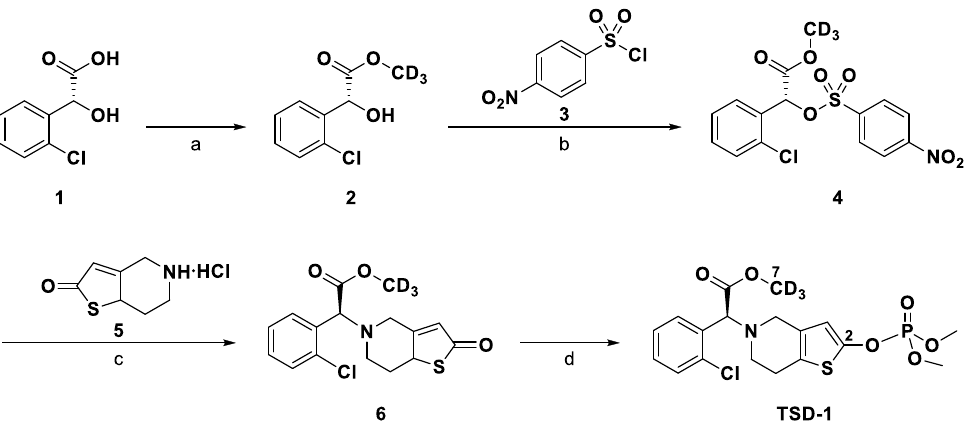
Figure 1. Synthetic route of TSD-1. Reagents and conditions: (a) methanol- d 4 , H 2 SO 4 , reflux; (b) DMAP, CH 2 Cl 2 , Et 3 N, −1 0 °C to −5 °C; (c) K 2 CO 3 , acetonitrile, r.t.; (d) dimethyl chlorophosphate, THF, DBU, −1 5 °C to −1 0 °C.